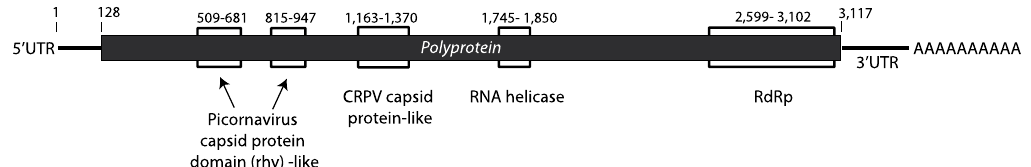
Figure 6. Diagram of putative organization of the LysV genome. Predicted proteins are marked with black boxes. Numbers above indicate nucleotide positions.